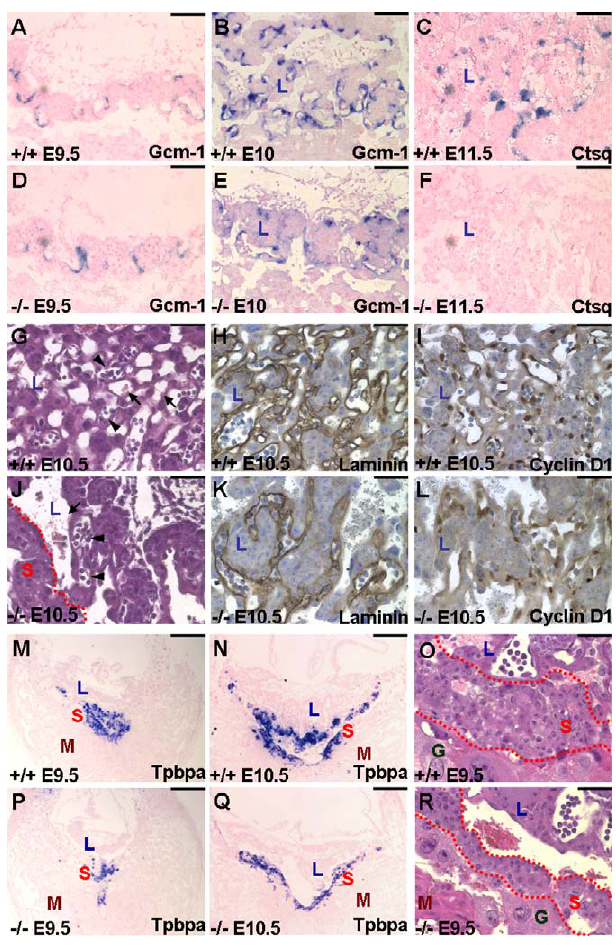
Figure 3. Developmental Defects of the SENP2-Null Labyrinth and Spongiotrophoblast Layers Sections of E9.5–E11.5 placentas were analyzed by in situ hybridization of Gcm1 (A,B,D,E), Ctsq (C,F), or Tpbpa (M,N,P,Q) and counterstained with nuclear fast red (A–F,M,N,P,Q), by histology (G,J,O,R) and immunostaining of laminin (H,K) or cyclin D1 (I,L), and by counterstaining with hematoxylin (H,I,K,L). (A,D) The Gcm-1-positive trophoblast precursors localized to the invasion site were found in both the E9.5 SENP2 þ / þ and SENP2 –/– placentas. (B,E) At E10, the SENP2 deletion caused an aberrant reduction in the Gcm-1 expressing cells. The Gcm-1-positive syncytiotrophoblasts failed to form an elongated multinuclear structure. (C,F) The Ctsq-positive cytotrophoblasts identified in the E11.5 wild-type labyrinth were missing in the mutant. (G,J) Arrows and arrowheads indicate maternal blood spaces surrounded by trophoblasts and fetal blood spaces surrounded by endothelia, respectively. (H,K) Laminin-labeled basement membrane, highlighting fetal blood spaces. (I,L) Cyclin D1 identified the proliferating endothelial cells. (M,N,P,Q) The number of the Tpbpa-expressing spongiotrophoblasts was drastically reduced by the loss of SENP2. (O,R) The thickness of the spongiotrophoblast layer, defined by broken red lines, decreased significantly. G, TGC; L, labyrinth; M, maternal decidua; S, spongiotrophoblast. Scale bars, 200 l m (A,D); 100 l m (B,C,E,F); 50 l m (G–L,O,R); 500 l m (M,N,P,Q).